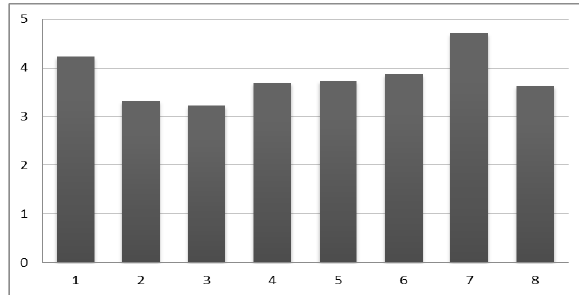
Figure 3. Results of the survey during the spring semester of 2011/12 academic year